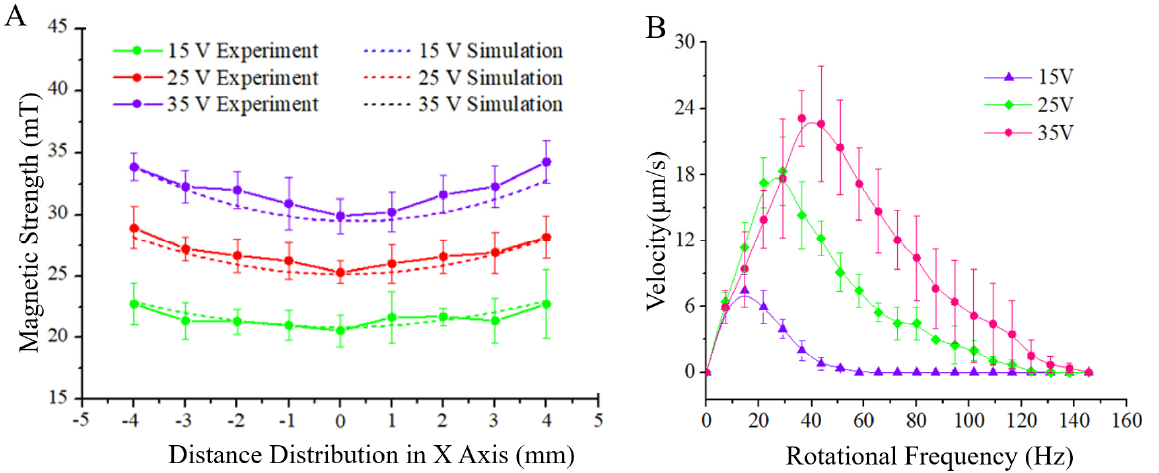
Figure 5. ( A ) Variation in magnetic strength in the workspace under different voltages. ( B ) Rela- tionship between the motion velocity of magnetic microrobots and the frequency of the input signal under various voltages.